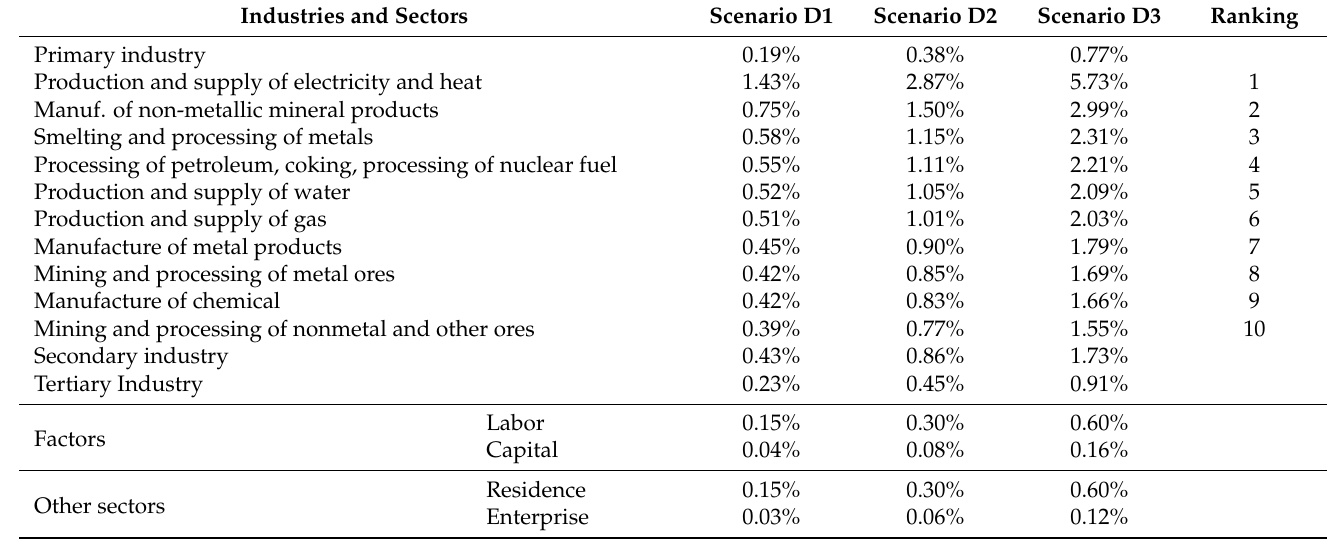
Table 8. Output and income changes of various industries and sectors based on raising coal